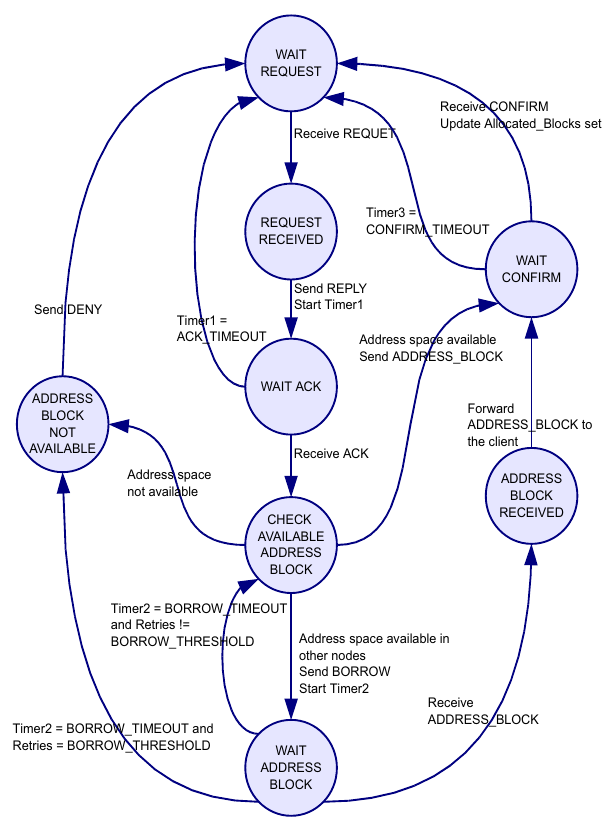
Figure 5. State diagram of a server node during the address allocation process of IPAA